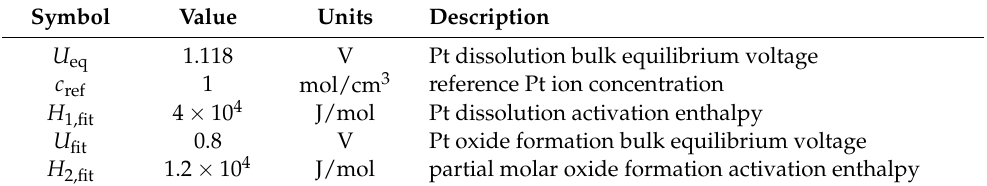
Table 3. Fitting